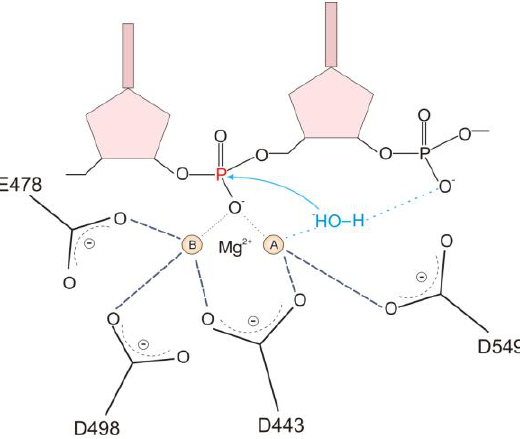
Figure 3. Schematic of the two-metal mechanism of RNase H hydrolysis. The active site metals are indicated as A and B. details are provided in the text. The figure was adapted from